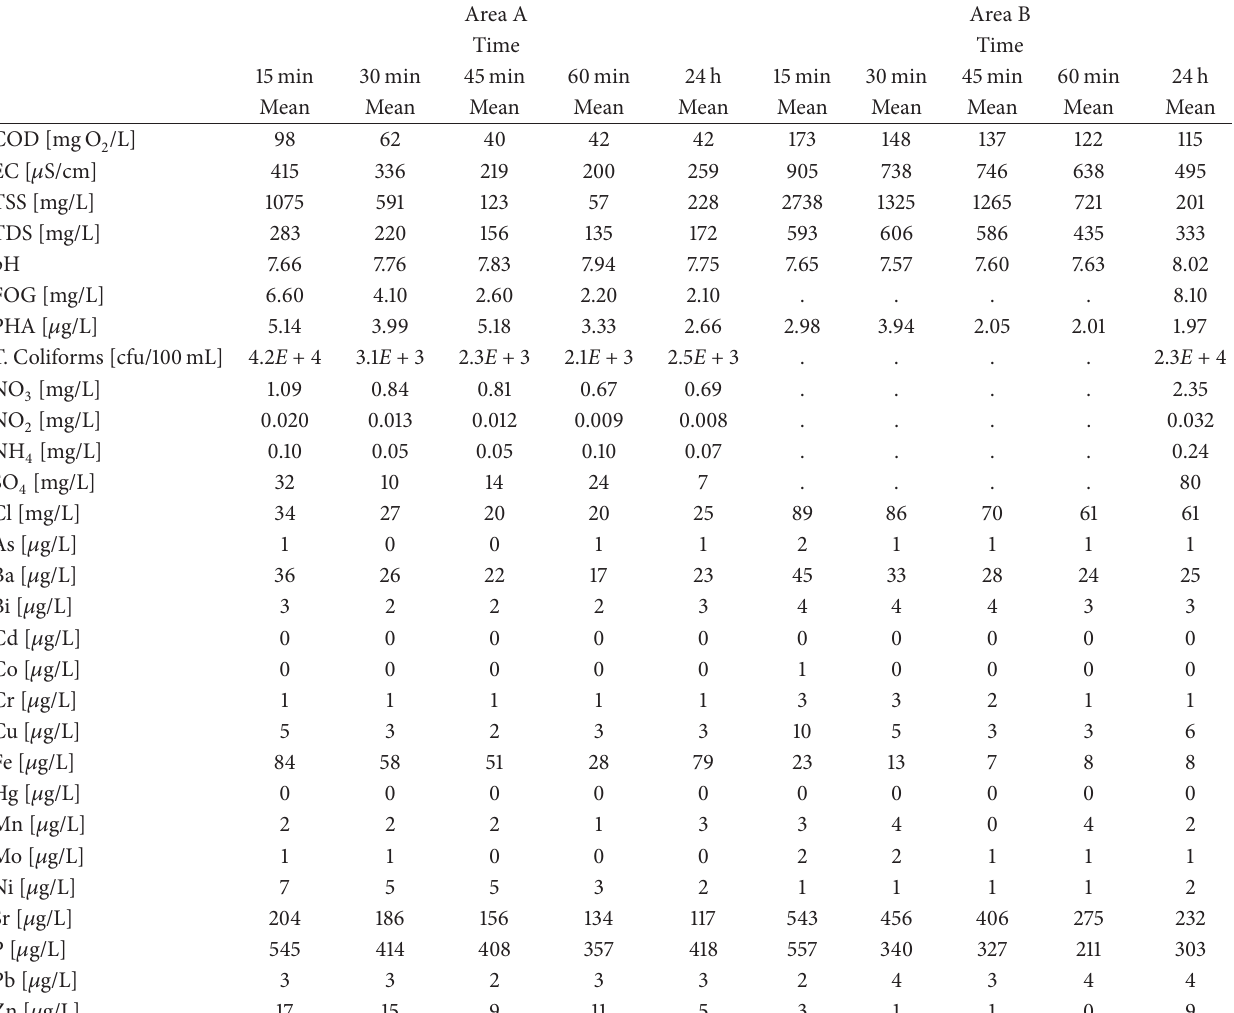
Table 2: Runoff physicochemical characteristics with respect to sampling